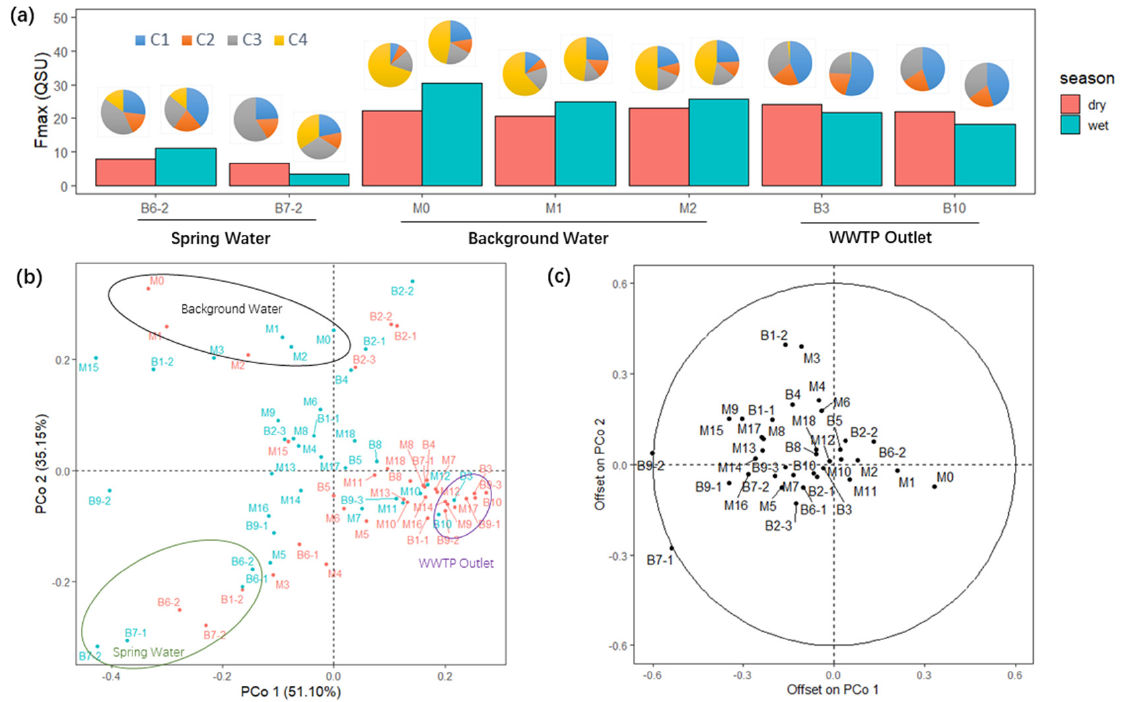
Figure 4. Spatiotemporal variations of fluorescent dissolved organic matter (FDOM) in the urban river system of Jinan, China. ( a ) F max and FDOM profiles of reference sites with different sources. ( b ) Principal coordinates analysis (PCoA) of Bray–Curtis distances of FDOM components. Labels in red and green indicate dry and wet seasons, respectively. ( c ) Offsets of studied sites in PCoA plot. Offset was calculated by locations in dry season minus those in wet season.